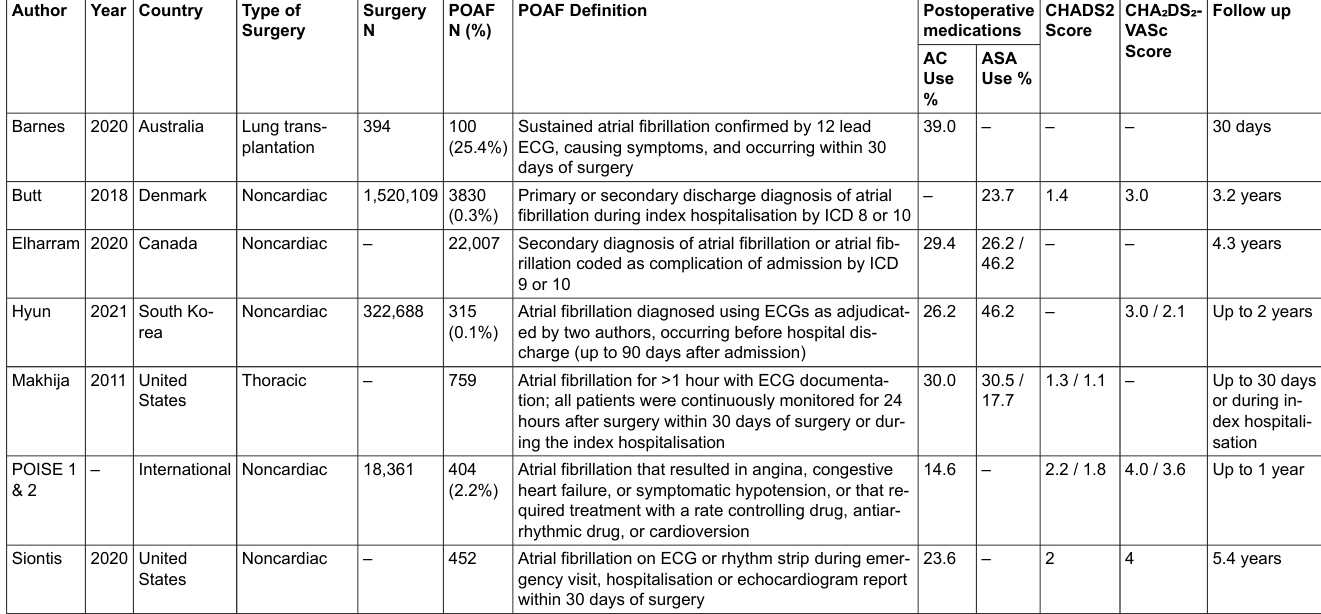
Table 1: Baseline characteristics of the 7 included studies. Baseline characteristics are presented as anticoagulation group / no anticoagulation group where available. Author Year